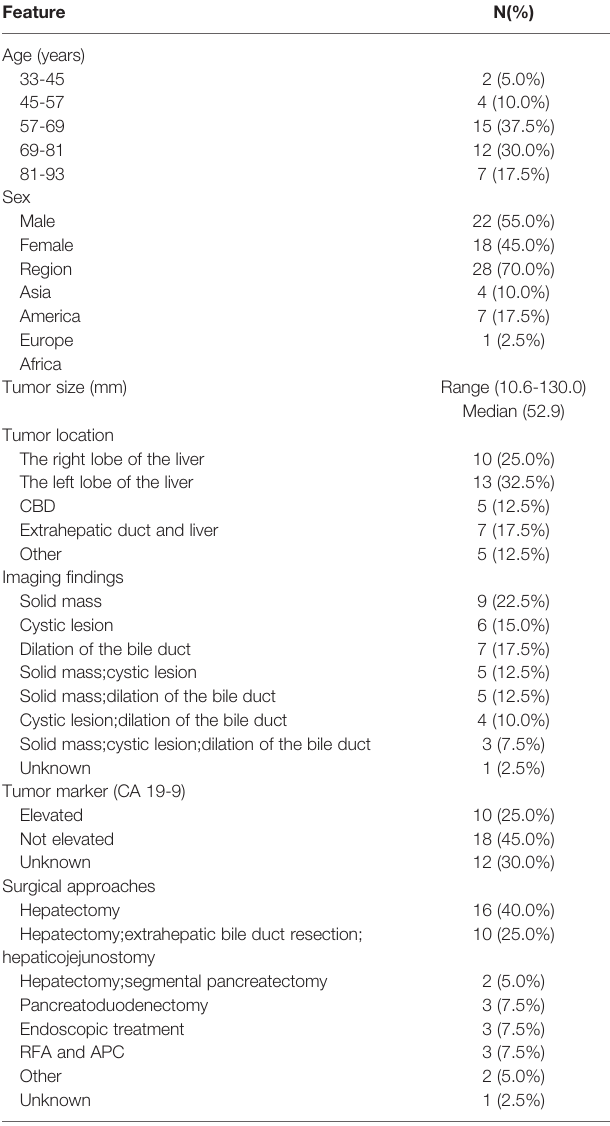
TABLE 2 | The demographic characteristics, clinical features and surgical approaches of IPNB. Feature